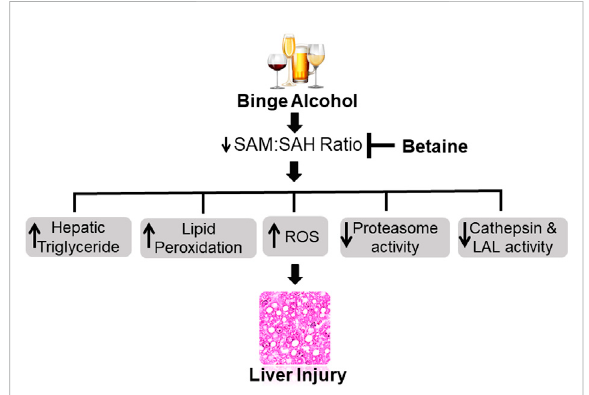
FIGURE 10 Schematic representation showing acute ethanol-induced liver injury is prevented by betaine administration. Ethanol binges primarily increases hepatocellular S-adenosylhomocysteine (SAH) levels while decreasing S-adenosylmethionine (SAM) generation. The consequent decline in intracellular SAM:SAH ratio causes many detrimental changes in the liver that collectively contribute to the development of liver injury. Betaine co- administration prevents the increase in SAH, promotes SAM generation and by normalizing SAM:SAH ratio attenuates acute ethanol-inducedliverdamage.ROS-reactiveoxygenspecies,LAL - lysosomal acid